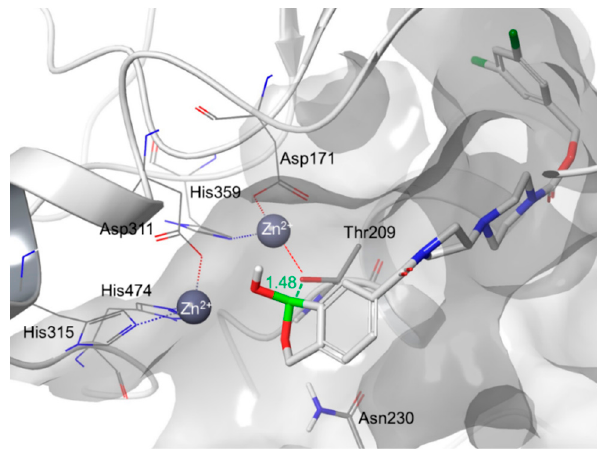
Figure 7. Compound 37 docked in the binding site of ATX using covalent docking. The covalent bond between the oxygen atom of Thr209 and the boron atom of boronate is labelled in green (d(O–B) = 1.48 Å).